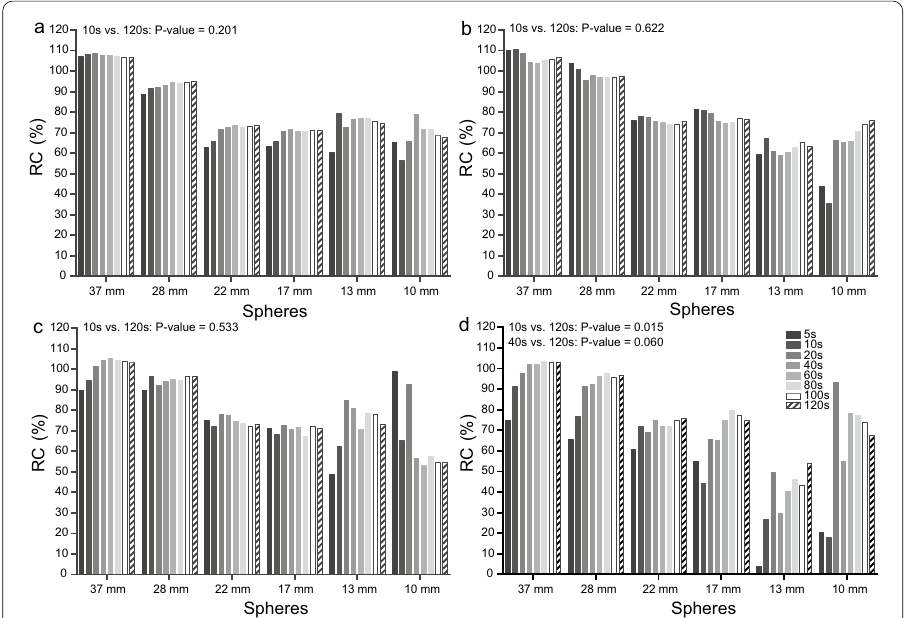
Fig. 7 RCs under different acquisition time. a 32:1 T/B ratio; b 16:1 T/B ratio; c 8:1 T/B ratio; d 4:1 T/B ratio; X-axis indicates different spheres grouped by size; Y-axis indicates RCs; RCs of each sphere were calculated with 5–120 s/frame of acquisition time (from left to right). P values were calculated by using the paired t-test. Fixed reconstruction parameters: 35 iterations, 20 subsets, no filter, AC acquisition parameters: 15% energy